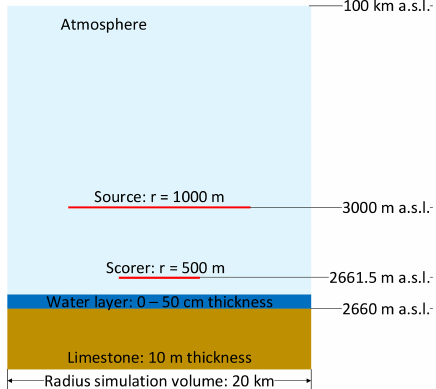
Figure 1. Geometry implemented in Geant4 to evaluate the effect of water layers of different heights above the